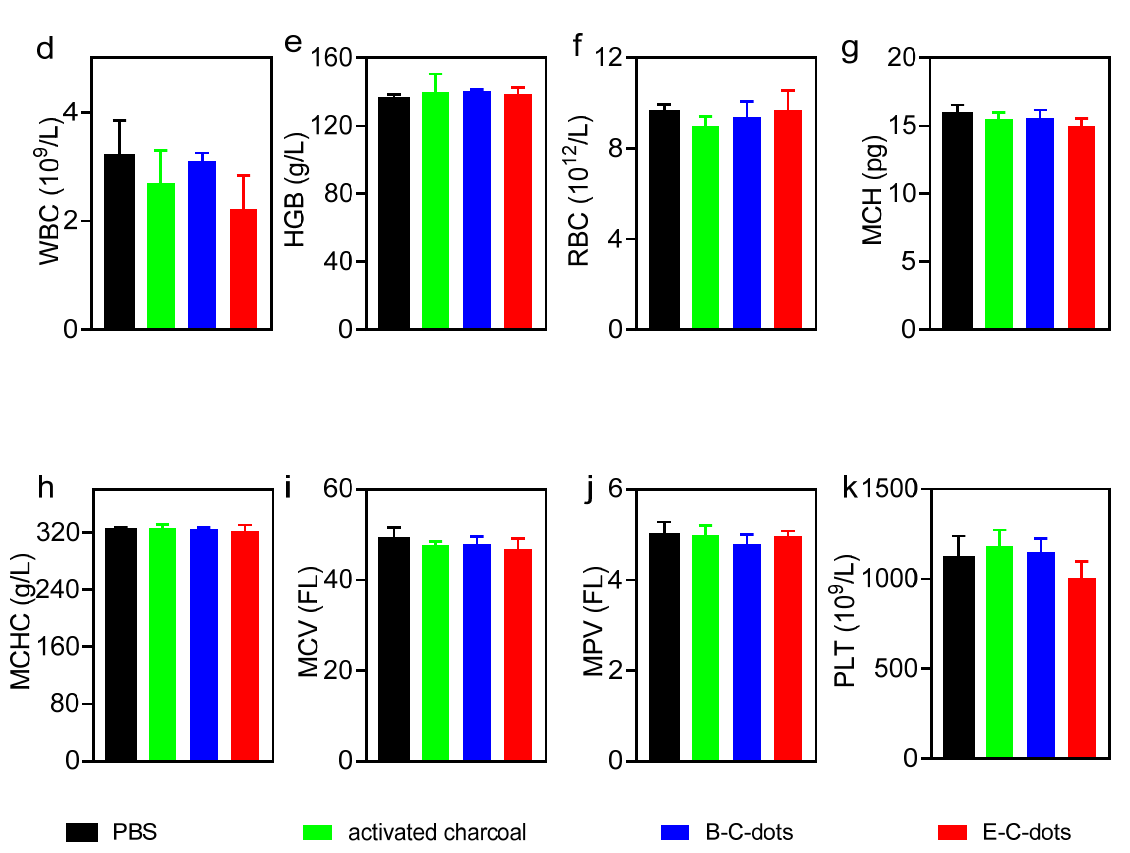
Figure 6. Blood analyses at sacrifice (day 14) of mice after administration of PBS, a commercial activated charcoal product (controls) or hydrothermally derived probiotic B-C-dots or pathogenic E-C-dots (daily dose 0.3 mg/mouse) for 14 days. ( a ) Alanine aminotransferase (ALT). ( b ) Alkaline phosphatase (ALP). ( c ) C-reactive protein (CRP). ( d ) White blood cells (WBC). ( e ) hemoglobin (HGB). ( f ) Red blood cells (RBC). ( g ) Mean corpuscular hemoglobin (MCH). ( h ) Mean corpuscular hemoglobin concentration (MCHC). ( i ) Mean corpuscular volume (MCV). ( j ) Mean platelet volume (MPV). ( k ) Platelets (PLT). Data represent averages over each group of three mice with error bars indicating standard deviations.